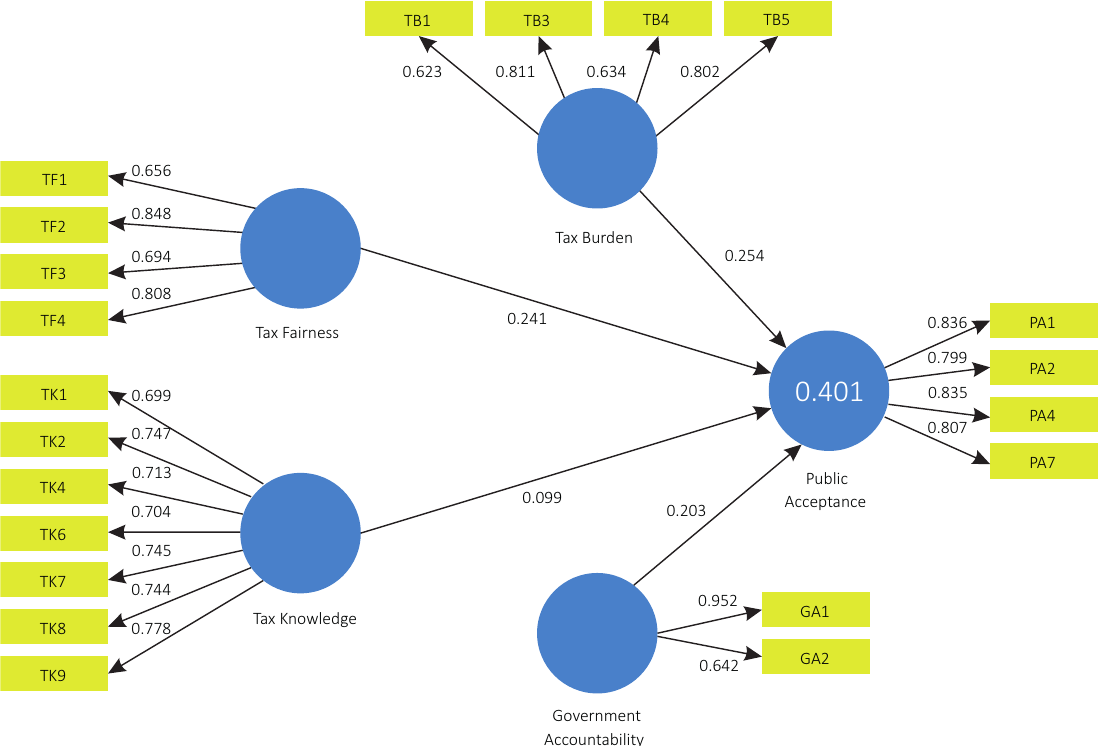
Figure 2. Measurement model (PLS algorithm) testing for reliability and validity and R 2